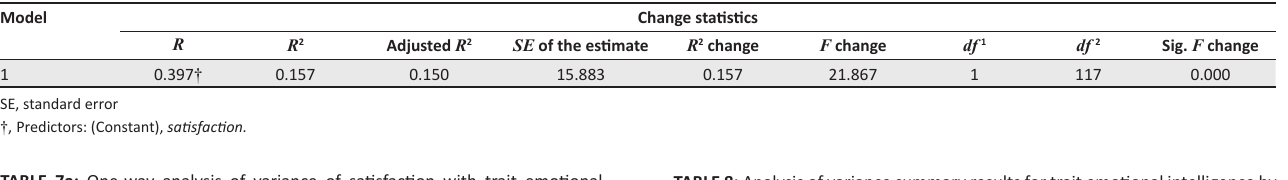
TABLE 7a: One-way analysis of variance of satisfaction with trait emotional intelligence as dependent variable. Model